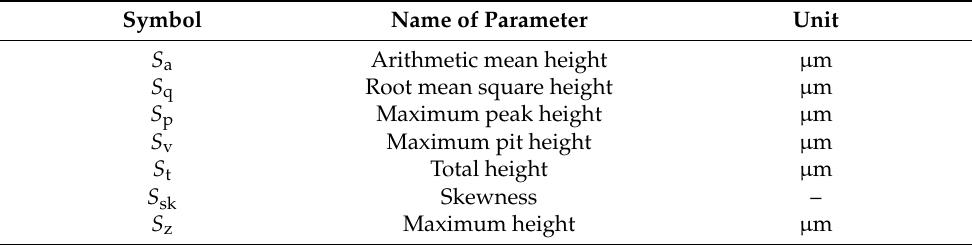
Table 1. Surface roughness amplitude parameters measured in